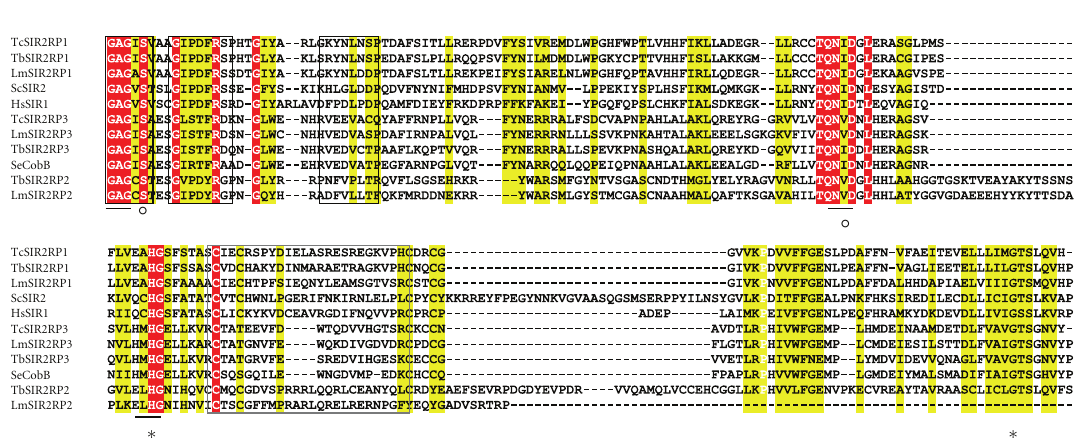
Figure 5: Class III deacetylases orthologues in trypanosomatids. Multiple sequence alignments of the core deacetylase domains from Tritryps and other organisms. Sequences were aligned with ClustalX2 followed by manual adjustment and illustrated with ESPript 2.2. Identical residues are white on red background and residues shared by some organisms are black on yellow background. Asterisks indicate residues that were predicted to form part of the catalytic pocket. The grey box marks the C2HC zinc-binding domain. Circles indicate NAD + -binding residues and asterisks indicate catalytic residues. The GAD and NID motifs as well as the conserved HG residues important for catalysis are underlined. Tb, Trypanosoma brucei ; Tc, Trypanosoma cruzi ; Lm, Leishmania mayor; At, Arabidopsis thaliana ; Hs, human; Sc, Saccharomyces cerevisiae; Sy, Synechocystis